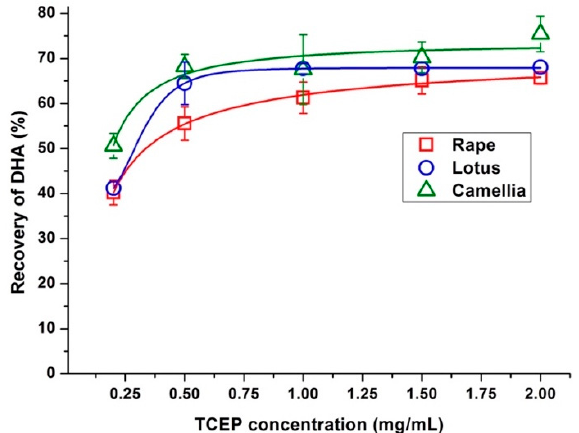
Figure 3. The trends of dehydroascorbic acid (DHA) recovery with increasing the concentration of tris-[2-carboxyethyl] phosphine (TCEP) in rape ( Brassica campestris ), lotus ( Nelumbo nucifera ), and camellia ( Camellia japonica ) bee pollen. The spiked content of DHA in bee pollen samples were 50 µg/g, and the concentration of TCEP in the 10 mL final extract were presented.